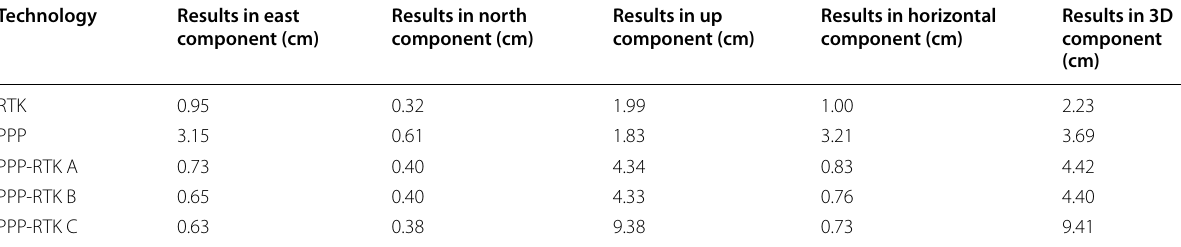
Table 4 Positioning accuracy statistics for the three techniques Technology Results in east Results in north component (cm) component (cm)